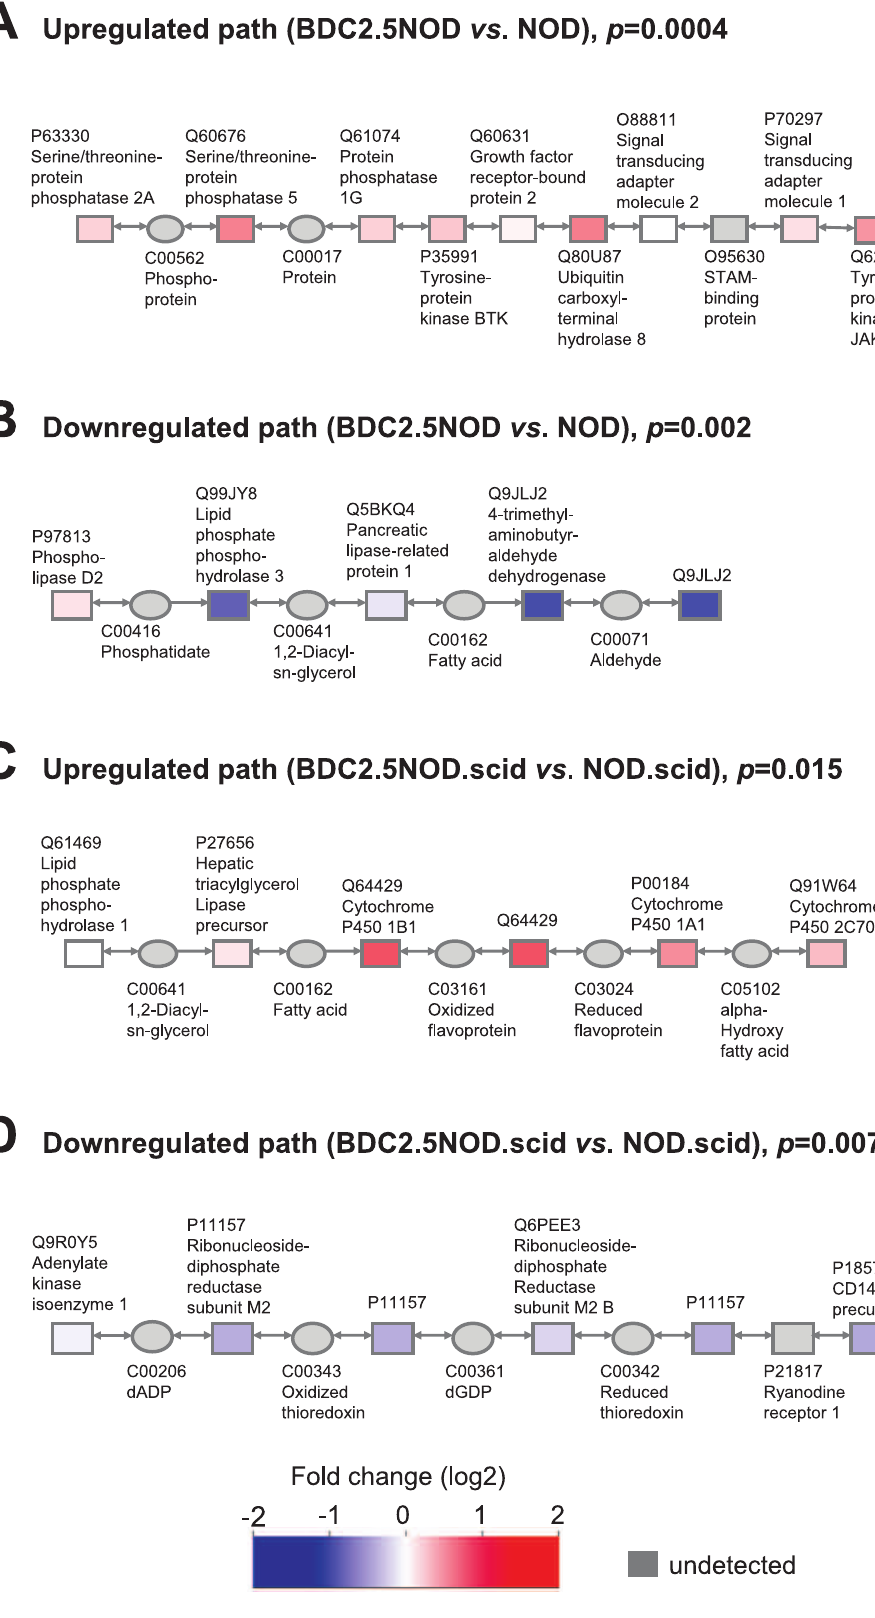
Figure 2. Selected paths significant in different case-control settings. Upregulated (A) and downregulated (B) paths related to insulitis. Upregulated (C) and downregulated (D) paths related to late insulitis and T1D.